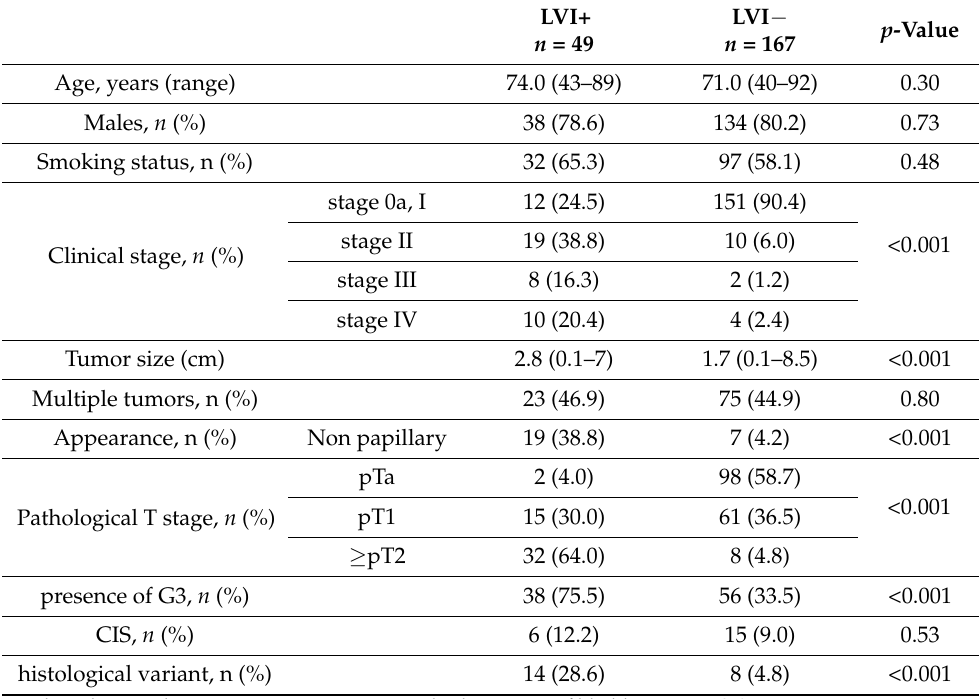
Table 1. Clinical and pathological characteristics stratified by LVI at first TURBT.